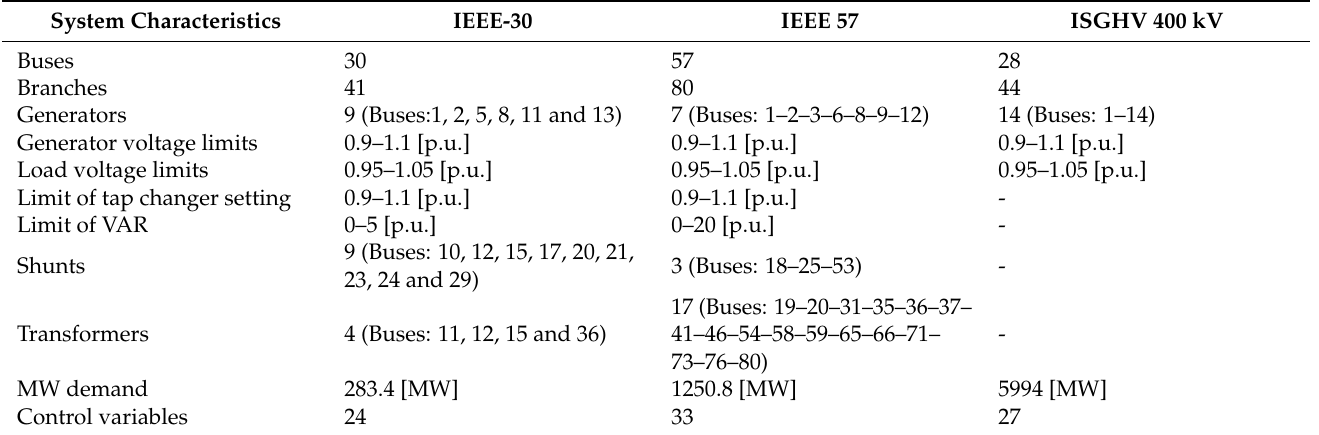
Table 1. The main characteristics of the systems applied in this